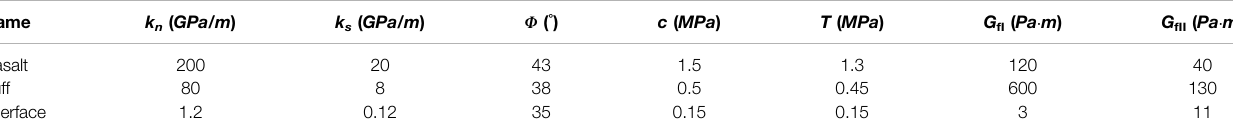
TABLE 3 | Parameters of the contact elements in the numerical